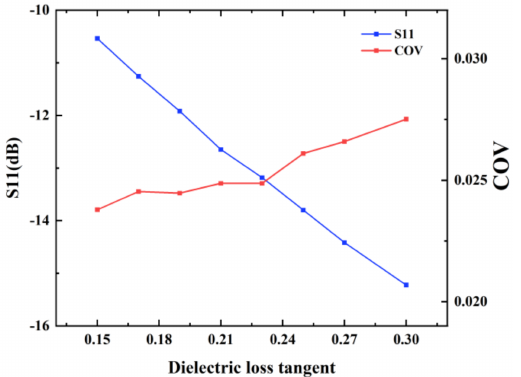
Figure 12. S11 and COV values of the microwave continuous-flow system for different dielectric loss tangents of the